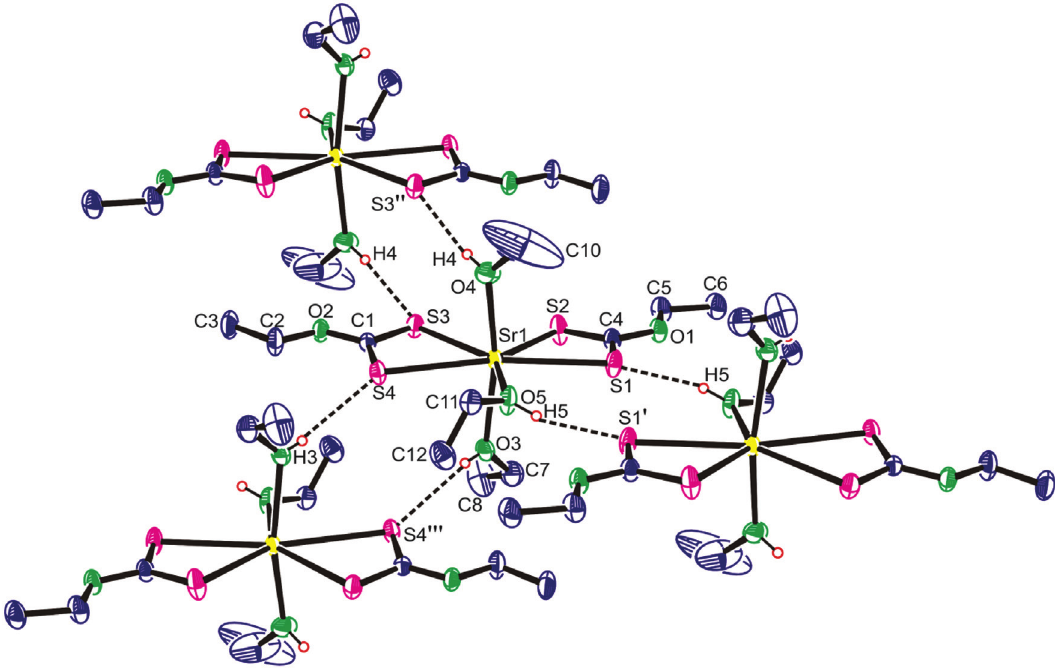
Figure 1 The asymmetric unit of 1 showing the labeling scheme used. Thermal ellipsoids are at the 30% probability level. C(9) is hidden behind C(10), whereas H(3) of the asymmetric unit [bonded to O(3)] is unlabeled. Only the O-H hydrogens have been included for clarity. Symmetry operations: ′1- x , 2- y , 1- z ; ″- x , 1- y , - z ; ‴1- x , 2- y , 1- z